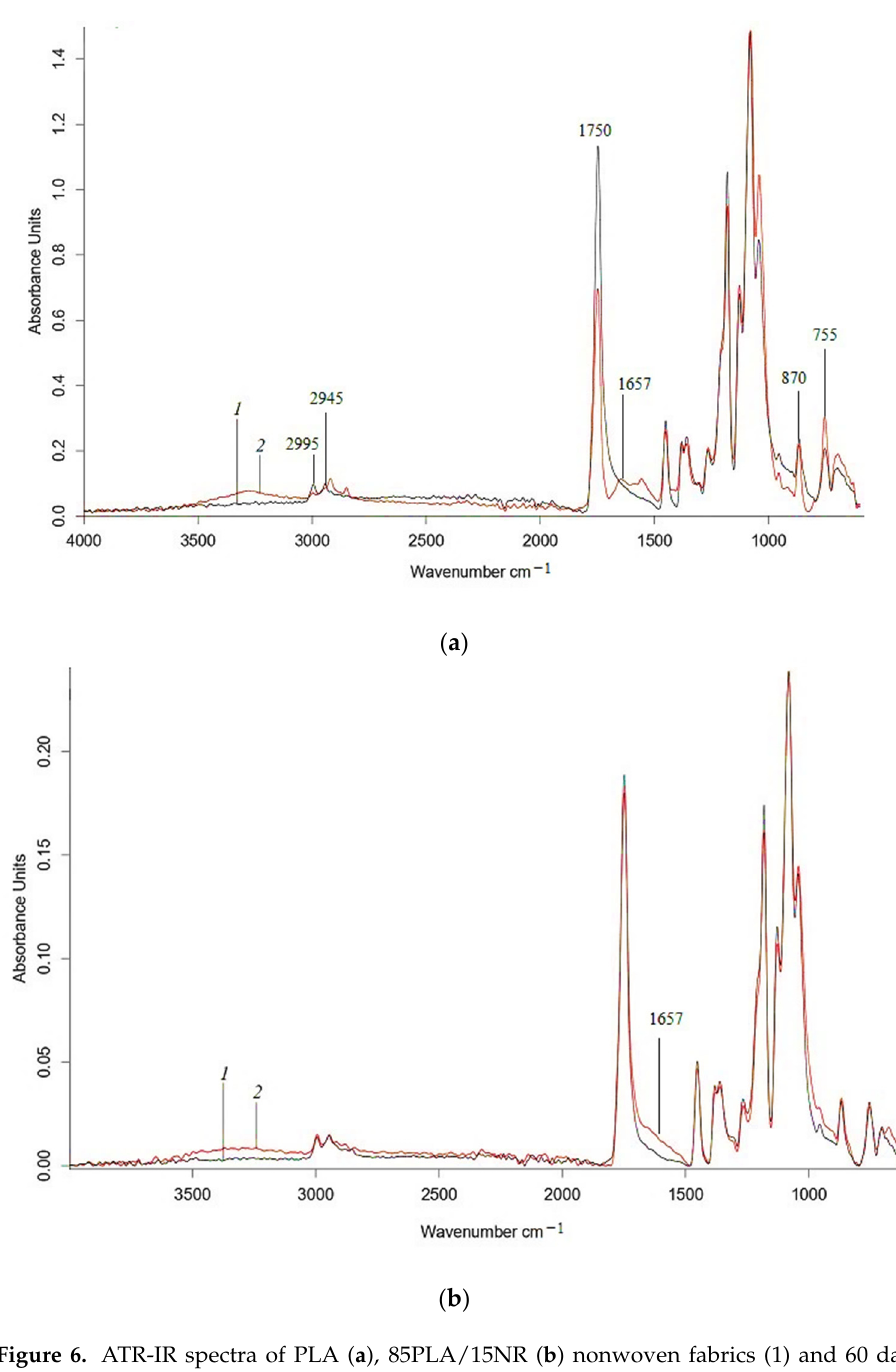
Figure 6. ATR-IR spectra of PLA ( a ), 85PLA/15NR ( b ) nonwoven fabrics (1) and 60 days after water